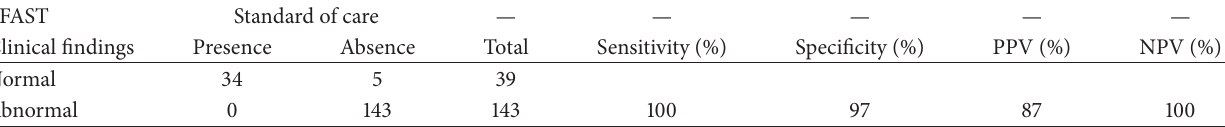
Table 3: Validity testing of EFAST taking standard of care as the gold